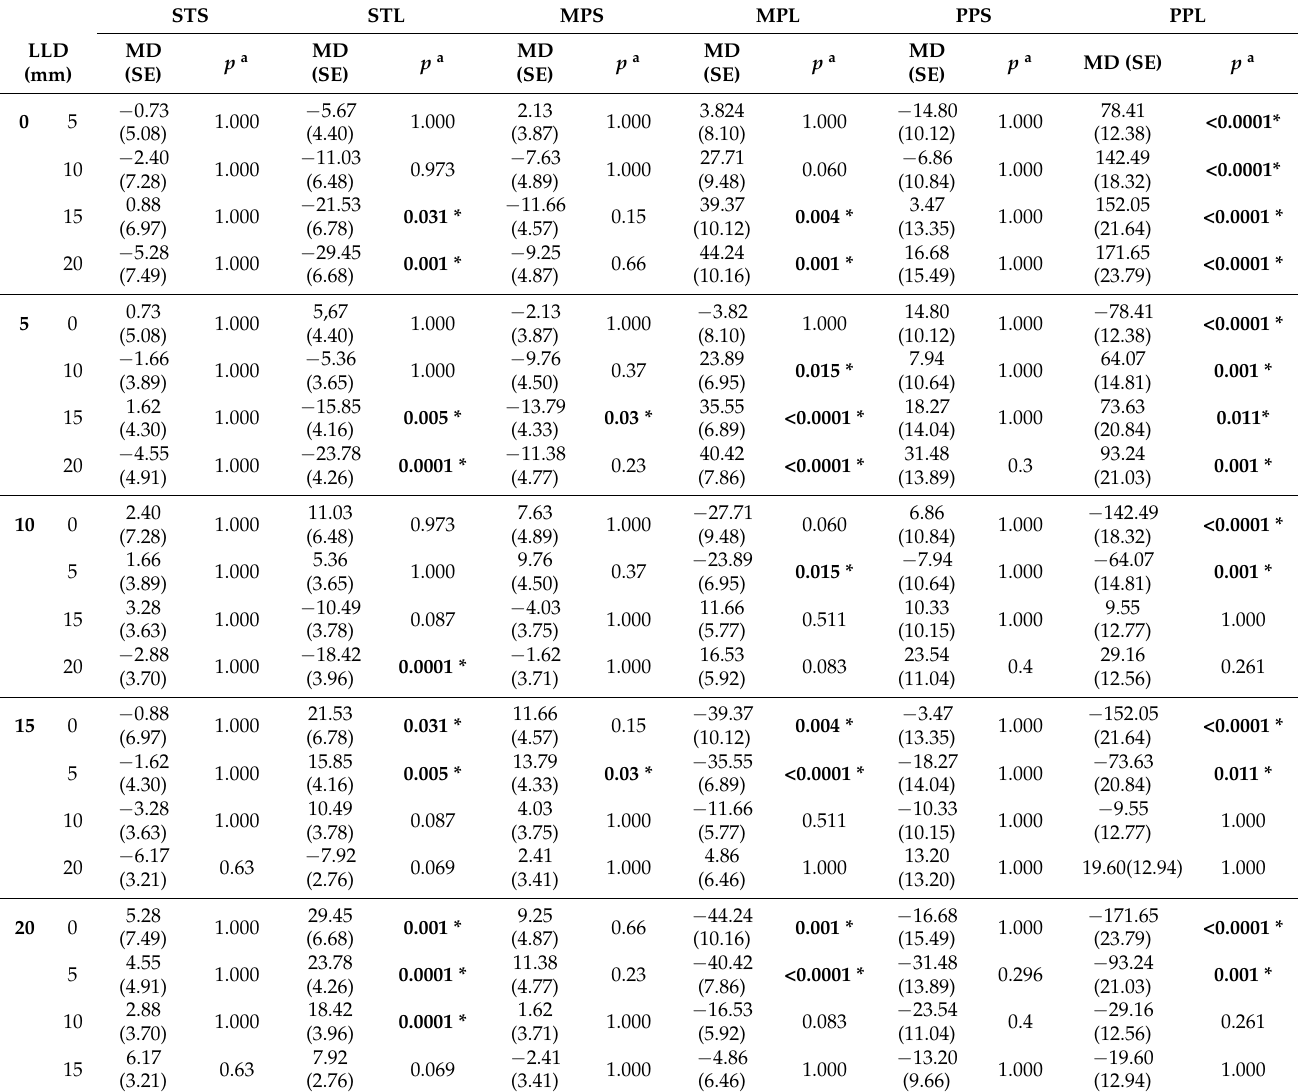
Table 5. Pairwise comparison based on estimated marginal